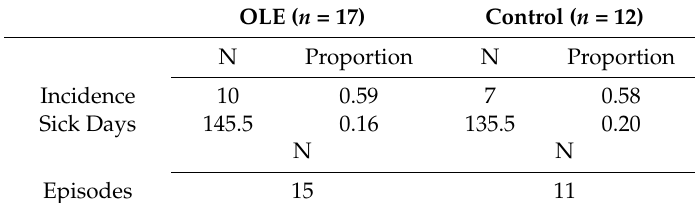
Table 2. Effect of olive leaf extract (OLE) on upper respiratory illness (URI) incidence and sick days.